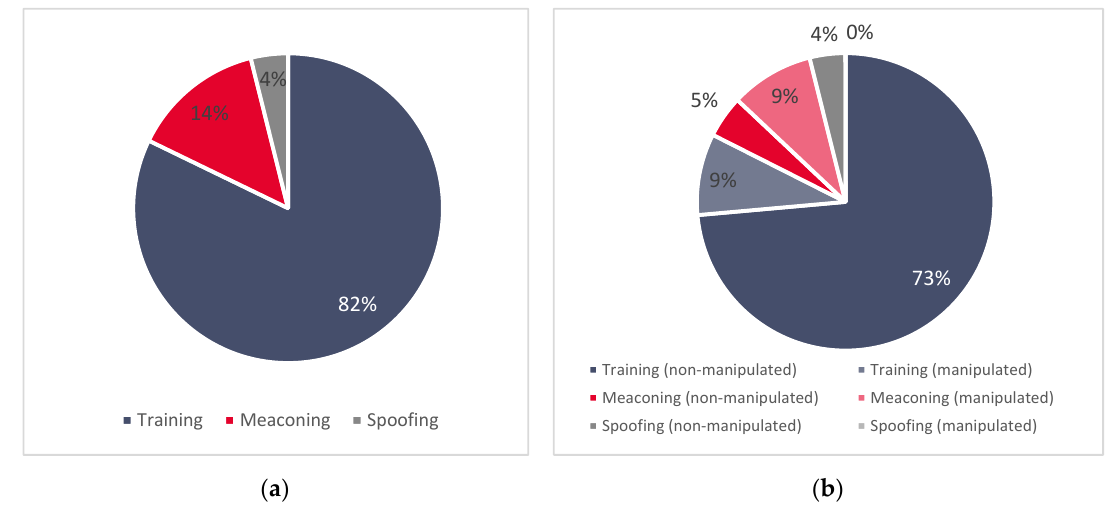
Figure 1. ( a ) Relative size proportions among three datasets and ( b ) the ratio of manipulated and non-manipulated GNSS signal records in each dataset.